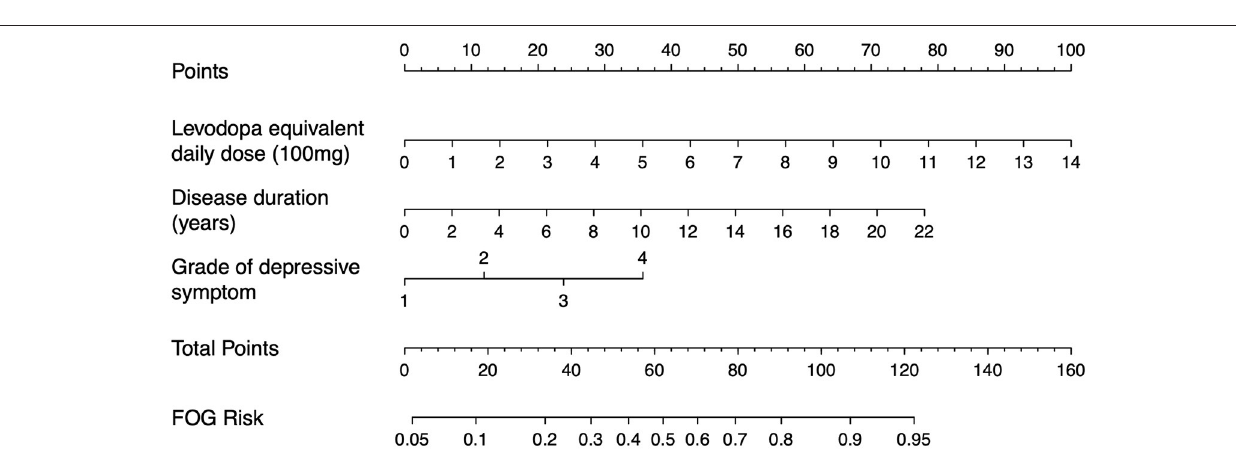
FIGURE 4 | Nomogram for the prediction of 2-year onset of FOG risk. The 2-year onset of FOG risk is calculated by taking the sum of the risk points. For each factor, the number of associated risk points can be determined by drawing a vertical line straight up from the corresponding value of factor to the axis with risk points (0–100). The total point axis (0–160) is the sum of the corresponding values of factor determined by characteristic of every individual patient. Draw a line straight down from the total point axis to find the 2-year onset of FOG risk. Grade of depressive symptom [1–4; none, mild, moderate, and severe based on the Hamilton Depression Rating Scale (HAMD) scores]. For example, patient with Parkinson’s disease with a 6-year disease duration, 700mg levodopa equivalent daily dose, and moderate depressive symptom may reach 94 total points, thus referring to an 82% 2-year onset of FOG